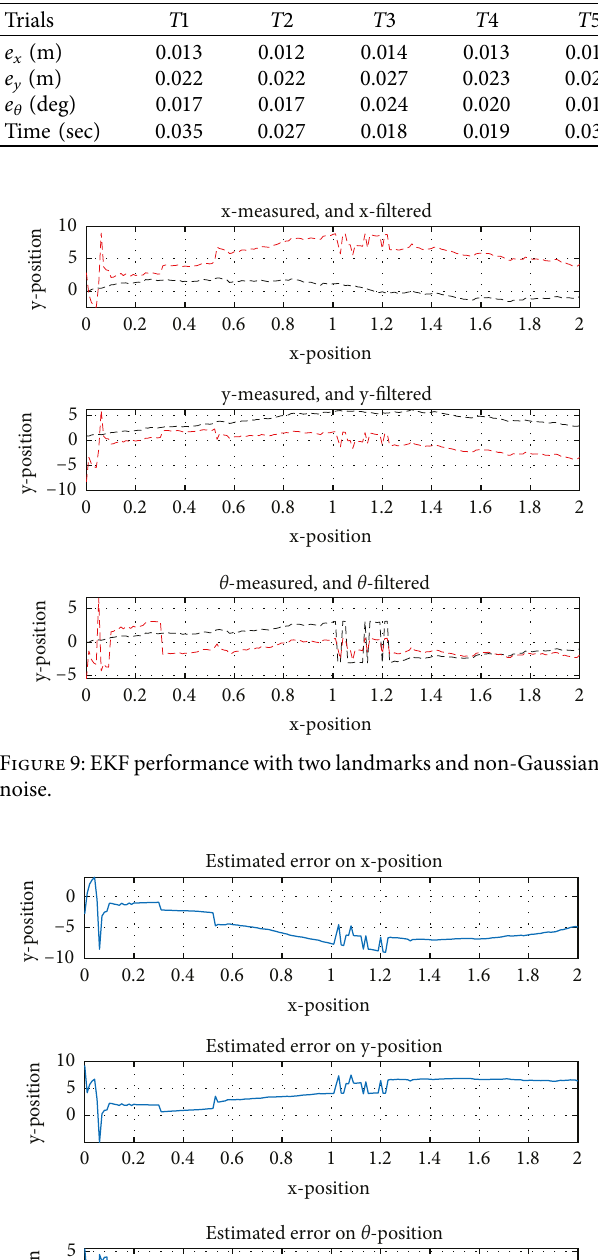
(1) Gaussian Noise . As shown in Figure 7, there are three different variation results for three different readings which are for measured and filtered results for the variables [ X , Y , θ ];